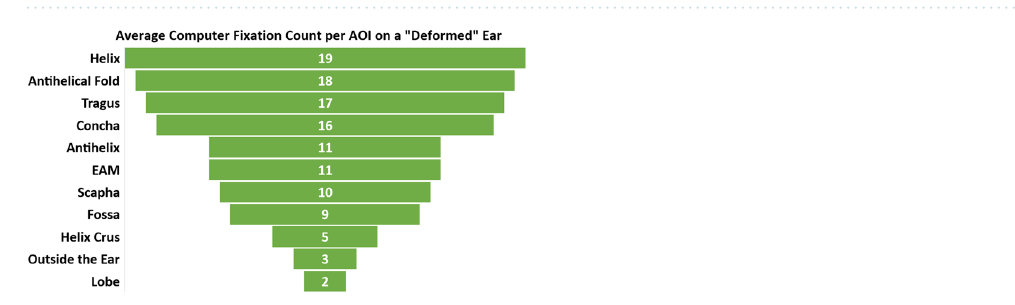
Figure 3. AOI that the machine used in determining the classification of ears based on Grad-Cam